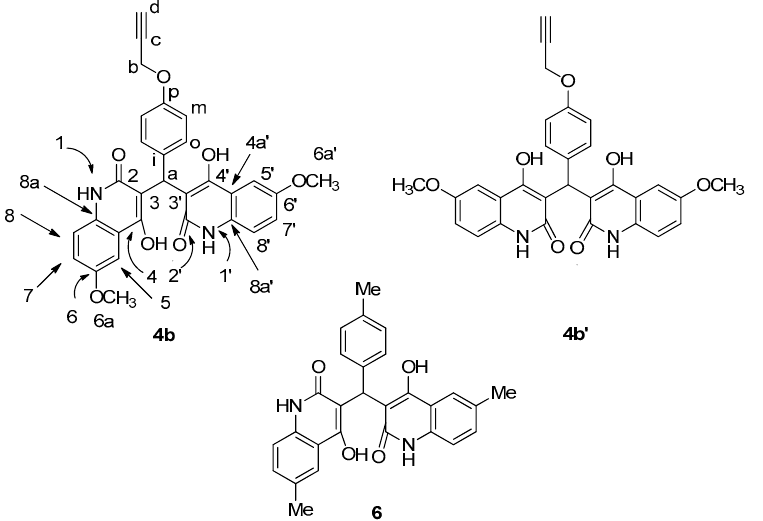
Figure 2. The structure of compound 4b , its tautomeric structure 4b’ , and analog compounds 6 . The 1 H NMR spectrum showed a characteristic four broad singlet signals at δ H = 13.39, 12.90, 12.19, and 12.08 ppm, integrating four D 2 O exchangeable protons assigned as OH-4/4’, OH-4’/4, NH-1/1’, and NH-1’/1, respectively. Additionally, a singlet at δ H = 6.14